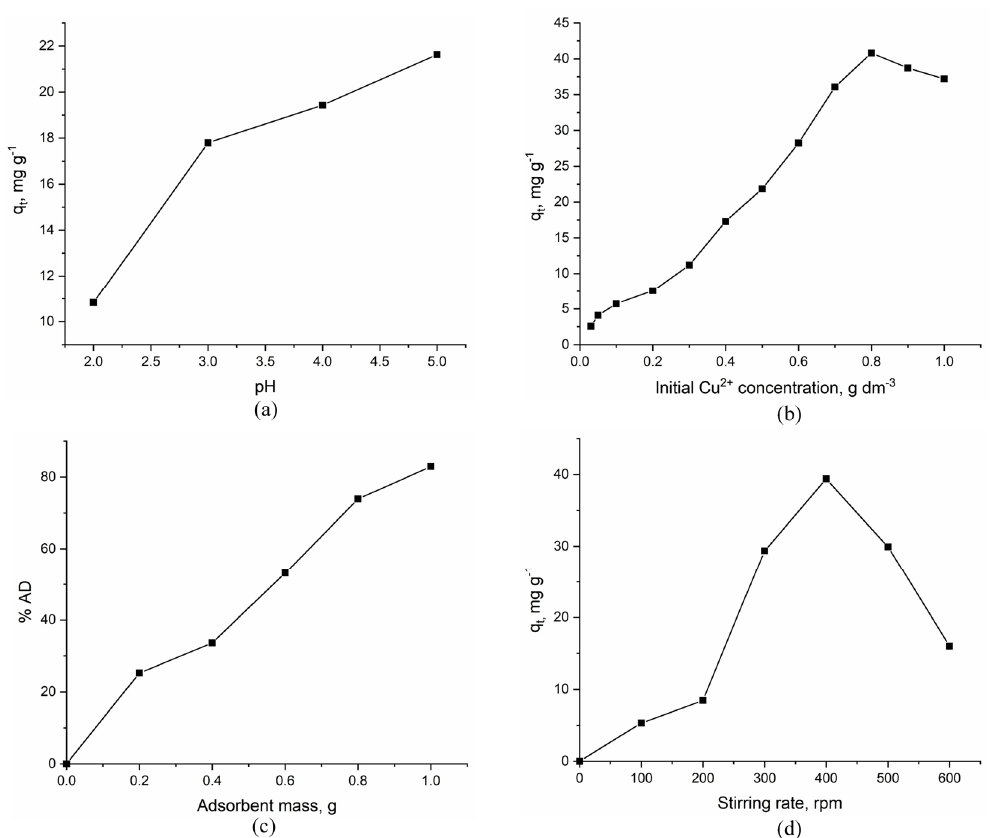
Figure 2. ( a ) pH value effect on the biosorption capacity, ( b ) initial Cu 2+ concentration influence